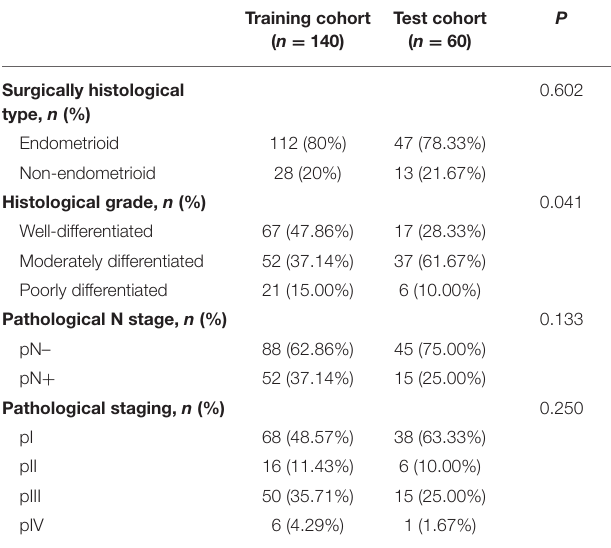
TABLE 3 | Pathological characteristics of the patients in our